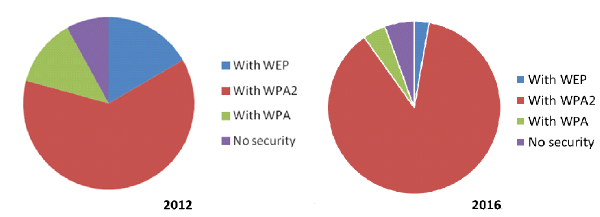
Table 3. Detailed capabilities of WLAN in Romania No. Capabilities